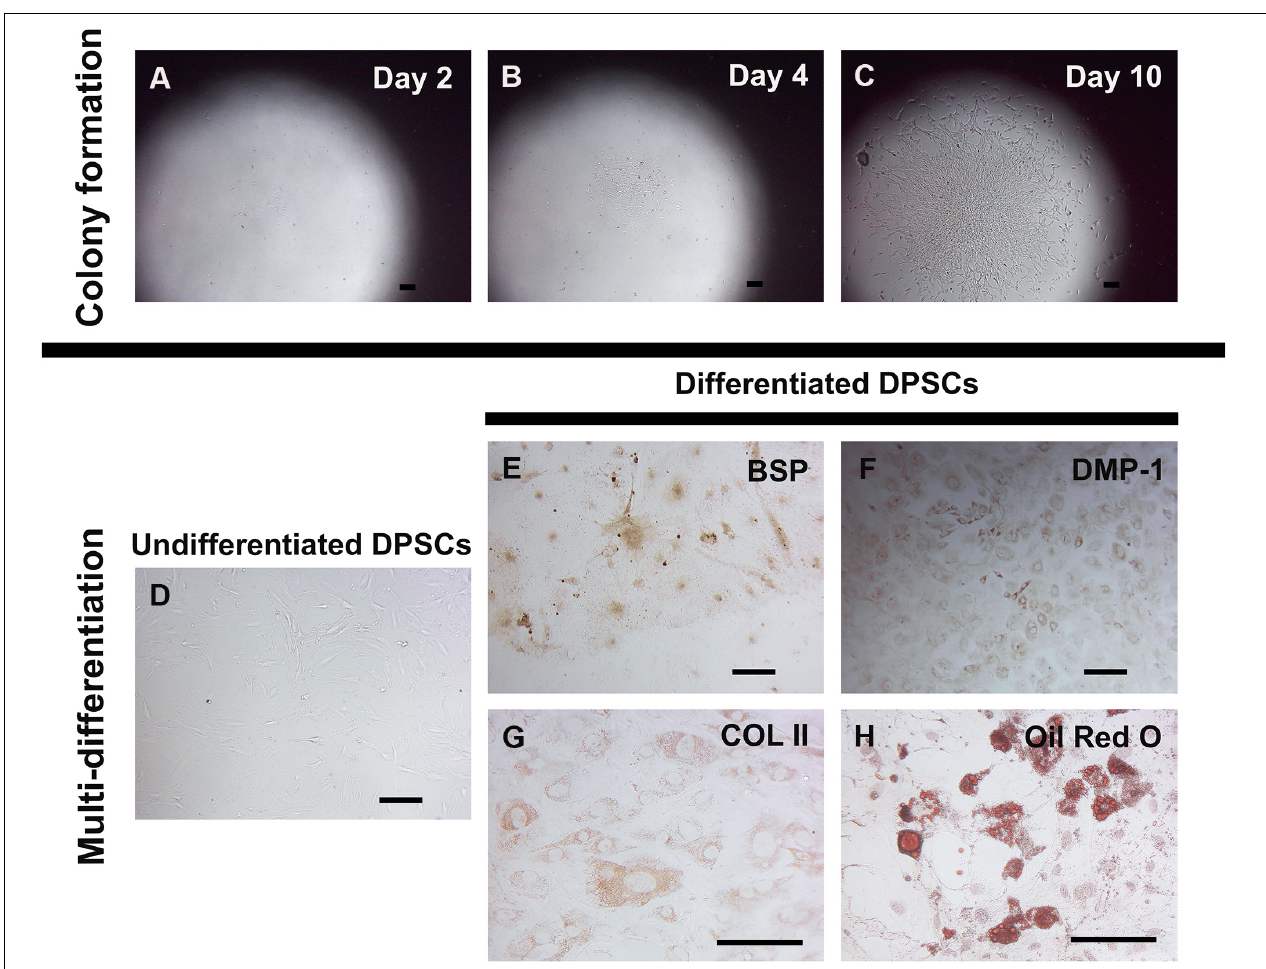
FIGURE 1 | Self-renewal and in vitro multi-differentiation of murine DPSCs. Murine DPSCs were isolated from dental pulp of neonatal lower molar teeth. A low density of cells (1000 cells/cm 2 ) were plated for several single cell depositions to observe a colony forming ability and characterize for their multi-differentiation. Representative figures show at the same spot of DPSC clone at different time points, Day 2 (A) , Day 4 (B) , and Day 10 (C) . The undifferentiated DPSC clone proliferated to gain the larger size, indicating its self-renewal property. The in vitro differentiation in various specific differentiation media demonstrates DPSC multi-differentiation potential. Undifferentiated DPSCs cultured in the stem cell media were spindle-shaped, indicating mesenchymal-like stem cell morphology (D) . Differentiated DPSCs cultured in the osteo-odontogenic media exhibited positive anti-BSP (in brown) (E) and anti-DMP-1 (in brown) (F) staining. Cultured in the chondrogenic media, differentiated DPSCs showed positive anti-COL II (in brown) (G) staining. Strongly positive Oil Red O staining (in red) (H) was seen in DPSC-derived lipid-containing cells in the adipogenic media. Scale bars indicate 100 µ